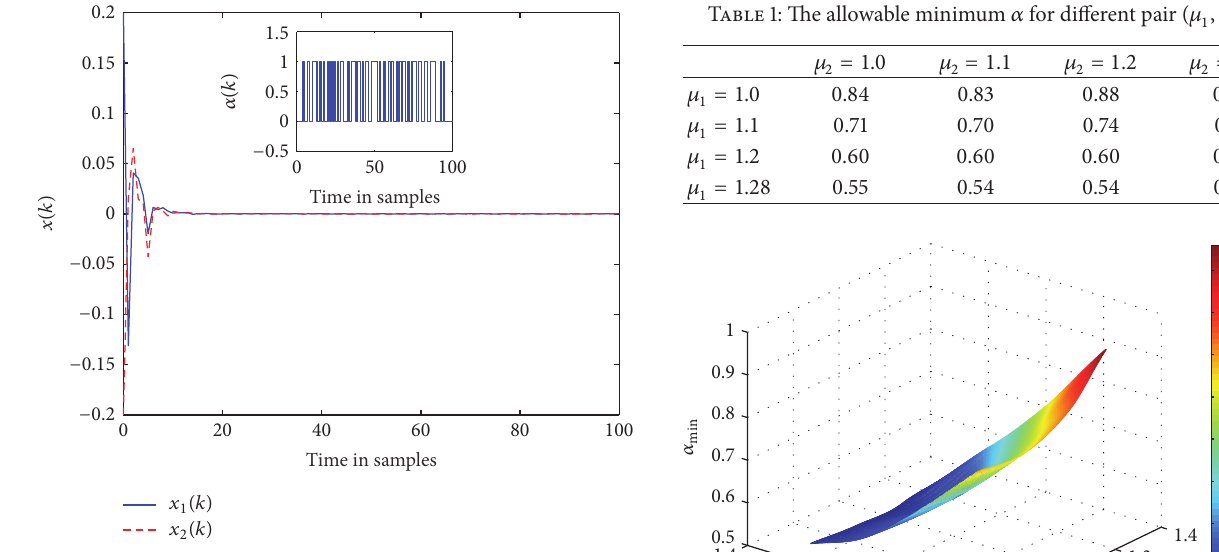
Figure 1: The simulation of the resulting closed-loop system.